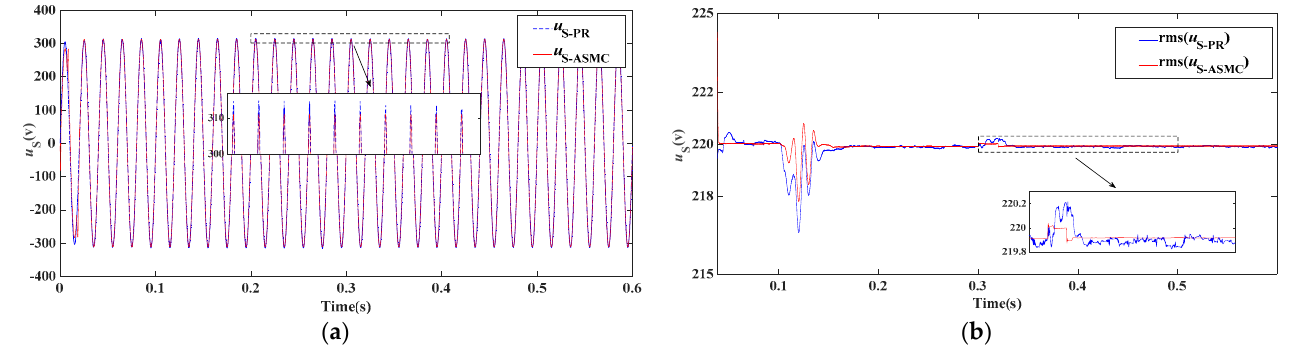
Figure 9. Voltage-stabilizing capacity of ASMC and PR control when L changes: ( a ) waveform Figure 10. Voltage-stabilizing capacity of ASMC and PR control when U DC changes: ( a ) waveform comparison, ( b ) RMS comparison. comparison, ( b ) RMS comparison.